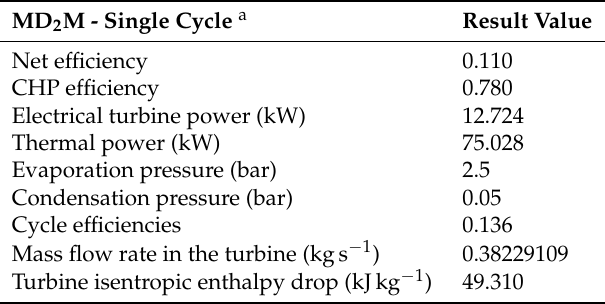
Figure 10. Net cycle efficiency and isentropic turbine power for binary cycles. Working fluids: MD 2 M for the bottoming (LT) cycle; p-terphenyl for the topping (HT) one. Table 3. Some results for a simple cycle. Working fluid MD 2